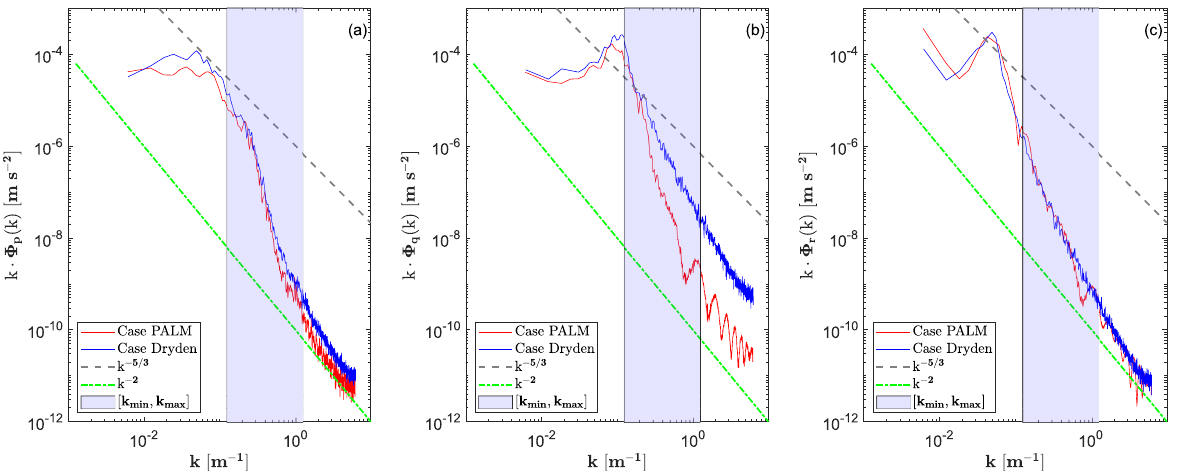
Figure 19. Spectra of airplane angular rate responses: ( a ) roll rate p , ( b ) pitch rate q and ( c ) yaw rate r , derived from flight simulation output data of scenario Passo del Bernina at an average altitude of 10,500 ft (3200 m). The grey dashed line represents the reference − 3/5-slope according to Kolmogorov’s law [71]. The dashed green line denotes the reference − 1-slope. The box in light blue shading indicates the time frame of interest for the flight simulation experiment, which is determined by the lower limit wave number k min of 2 π /50 m − 1 and the high limit wave number k max of 2 π /5 m − 1